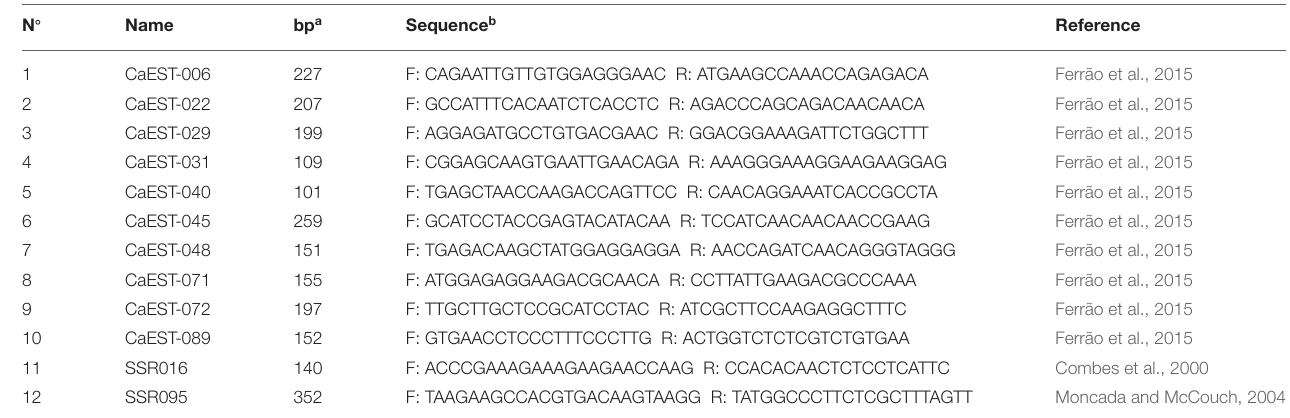
TABLE 5 | SSR primers used to amplify the genomic